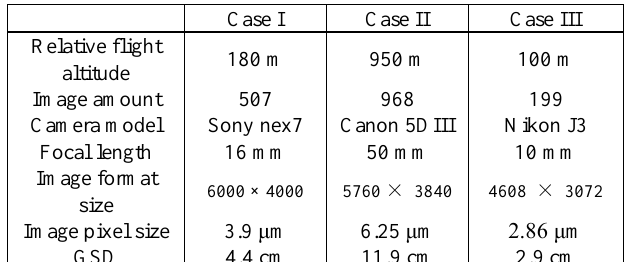
Figure 2 Tracking map with thumbnail photos rotated.